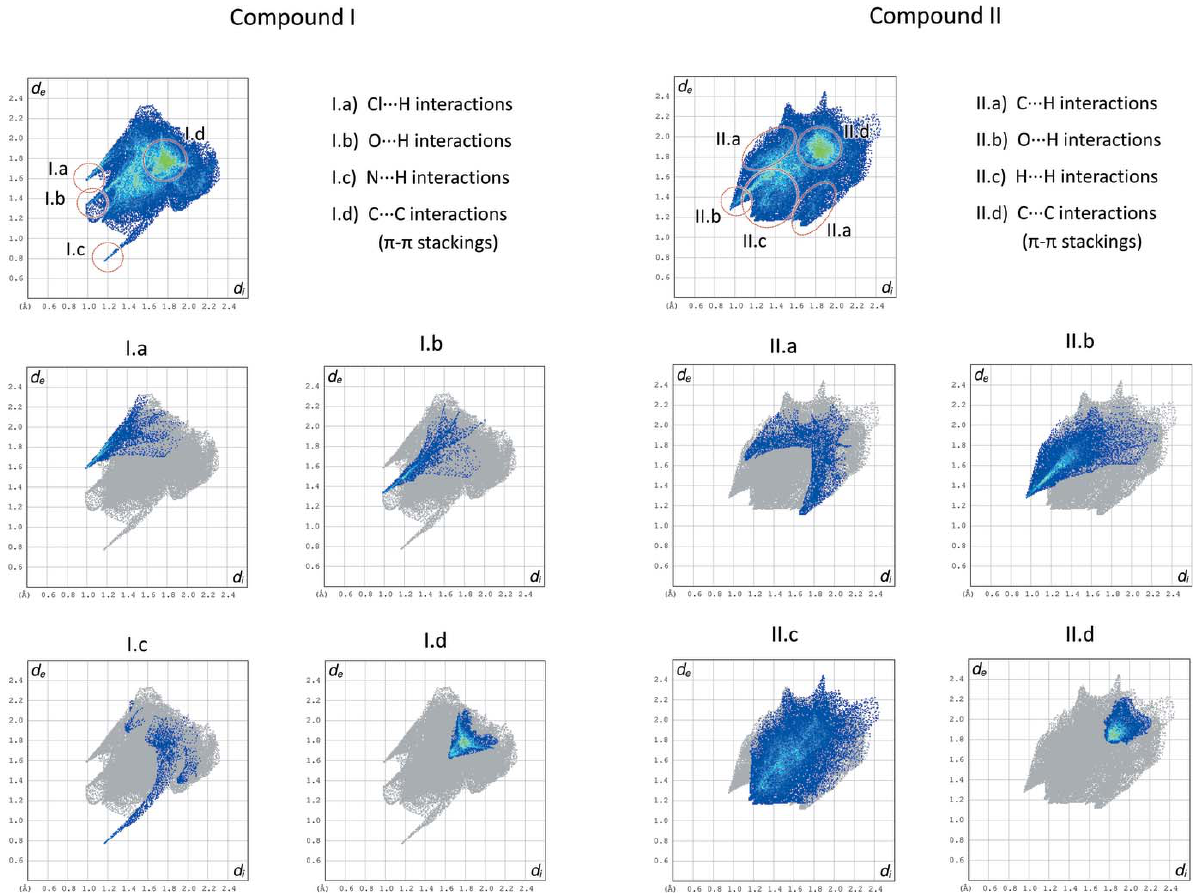
Figure 7 Hirshfeld fingerprint plots of compounds ( I ) and ( II ) (above) and some relevant components (I.a–d and II.a–d), highlighting the main interactions exhibited by MB + in the respective solid